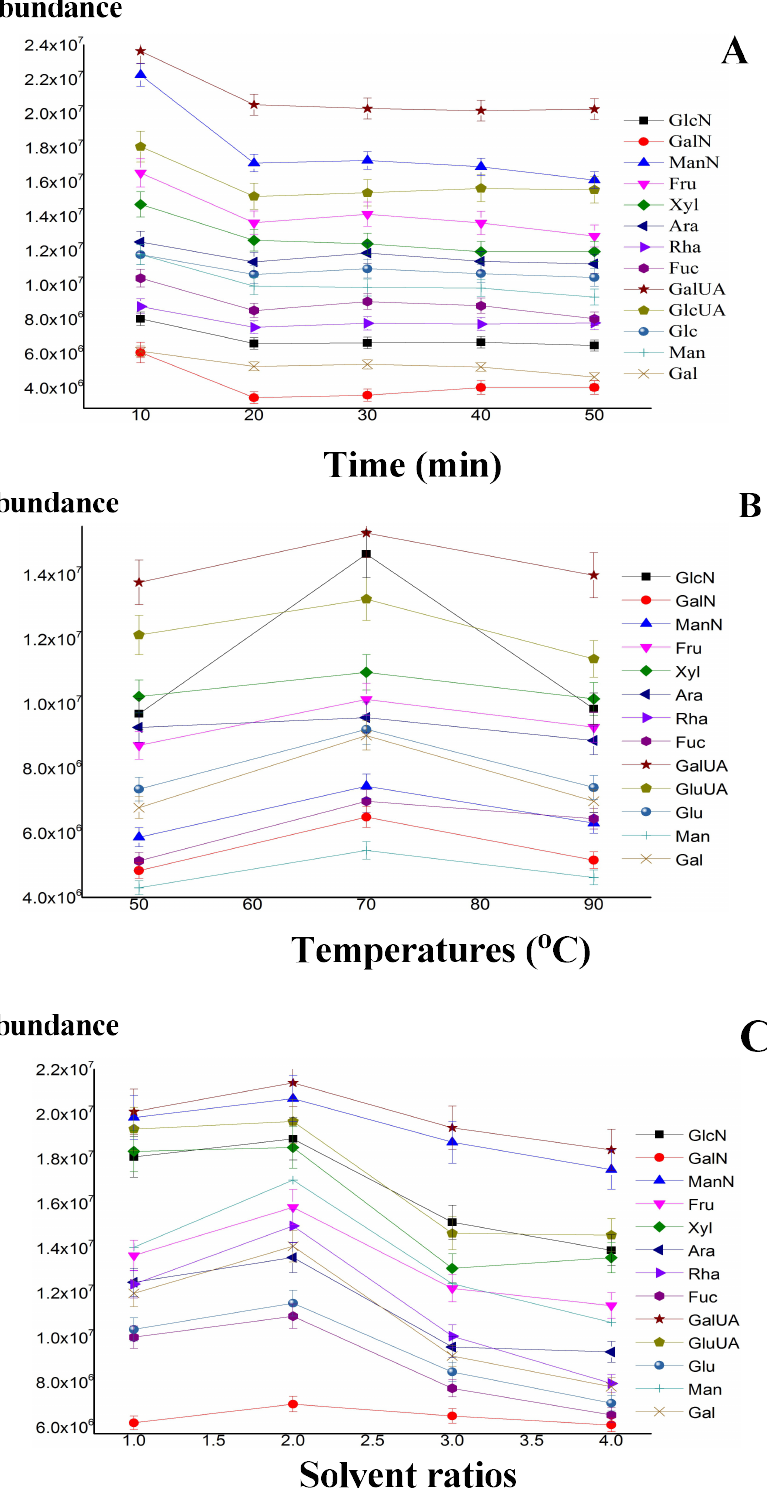
Figure 1. Effects of derivatization time on monosaccharide-mercaptalated ( A ), effects of both TMS derivatization temperatures ( B ), and solvent ratios between HMDS and TMCS ( C ) on formations of TMSDs.